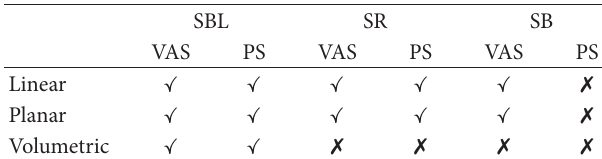
Table 5: Current applicability status of the three